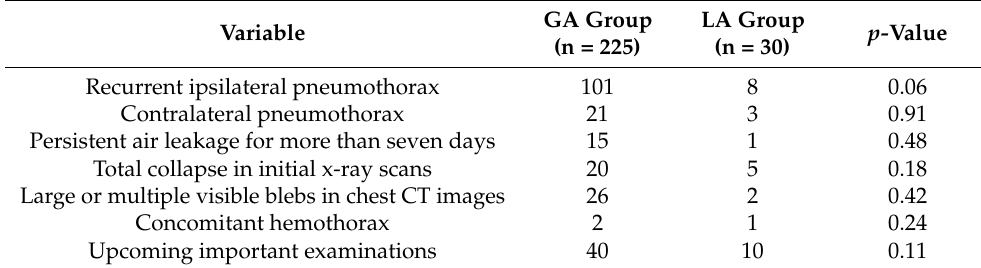
Table 1. Prevalence of indications in each